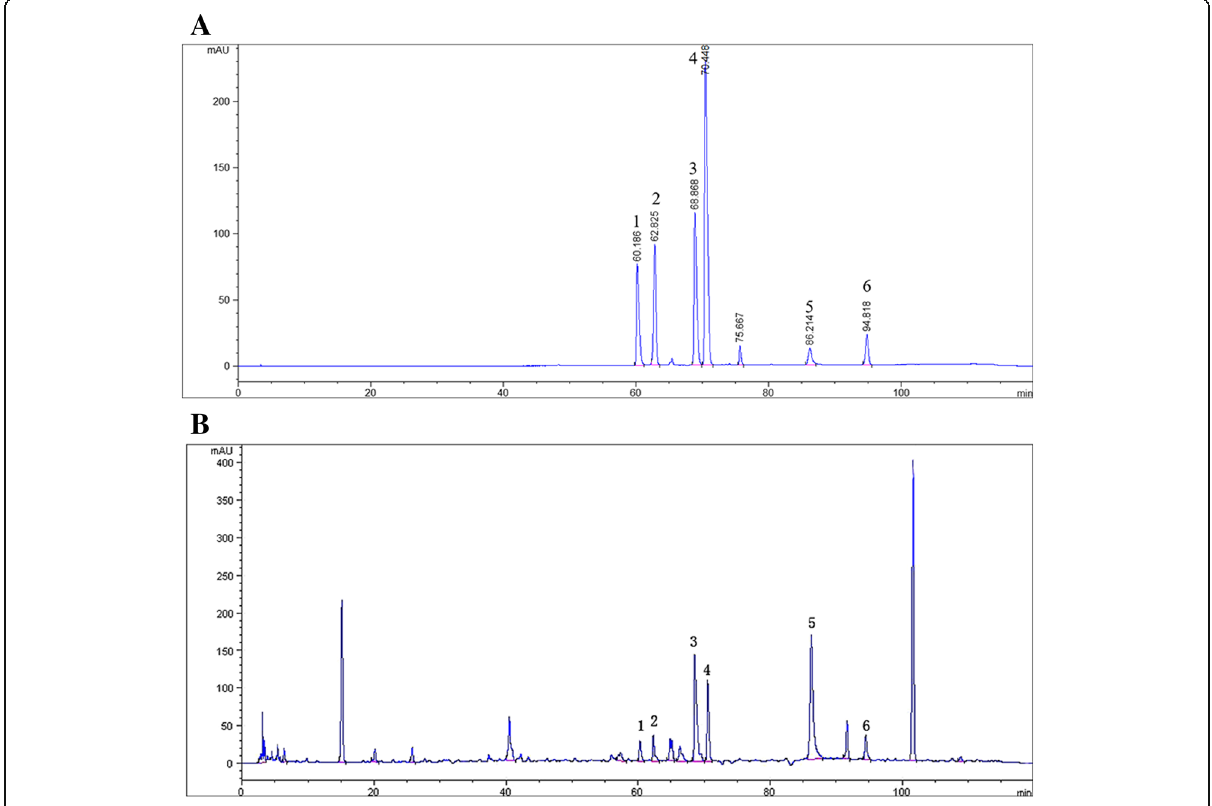
Fig. 1 HPLC fingerprint chromatogram of WMW extracts. HPLC fingerprint chromatograms of the extracts of the reference standards ( a ); WMW ( b ). In the chromatograms, (1) coptisine (PubChem CID:72321); (2) ferulic acid (PubChem CID:445858); (3) berberine hydrochloride (PubChem CID:12456); (4) palmatine hydrochloride (PubChem CID:73442); (5) cinnamaldehyde (PubChem CID:637511); and (6) asarinin